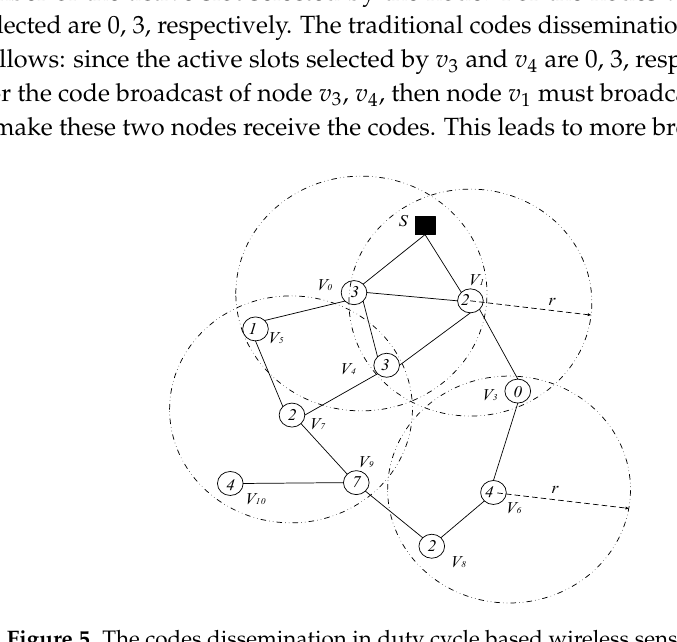
Figure 5. The codes dissemination in duty cycle based wireless sensor network.